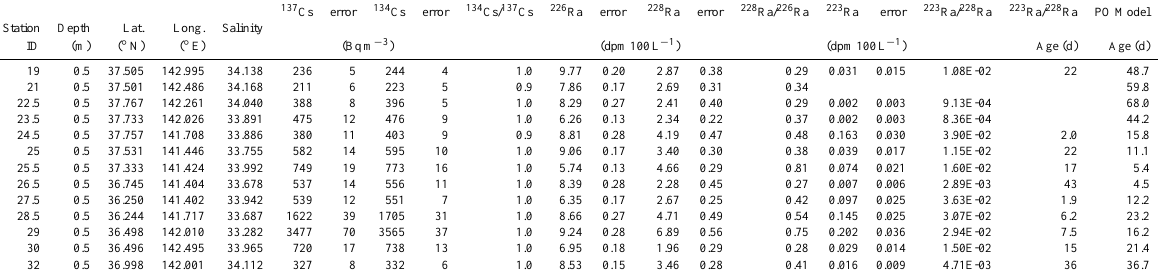
Table 1. Radium and Cs isotopes for stations were MnO 2 acrylic fibers were used.